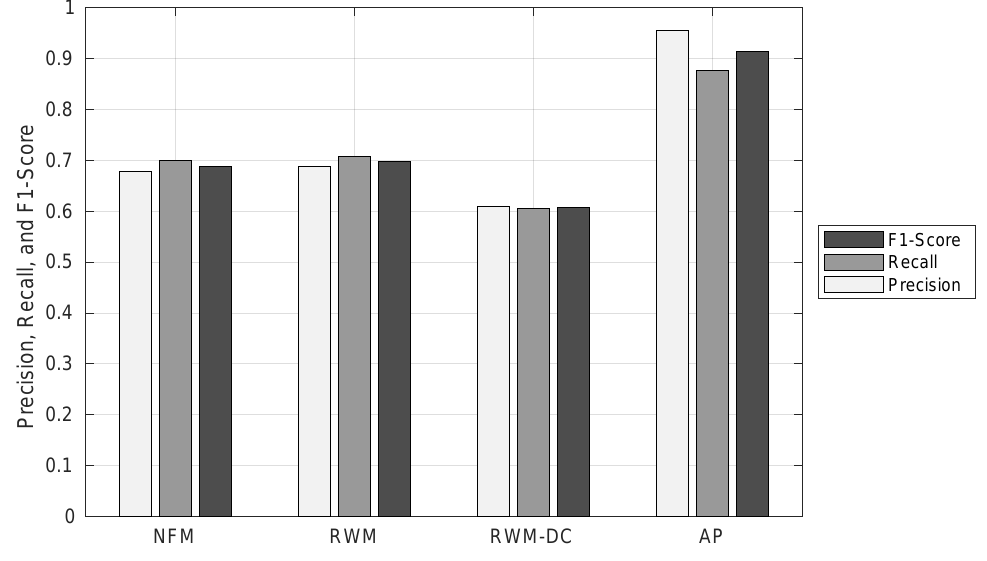
Figure 14. Precision, recall, and F1-score of node matching.